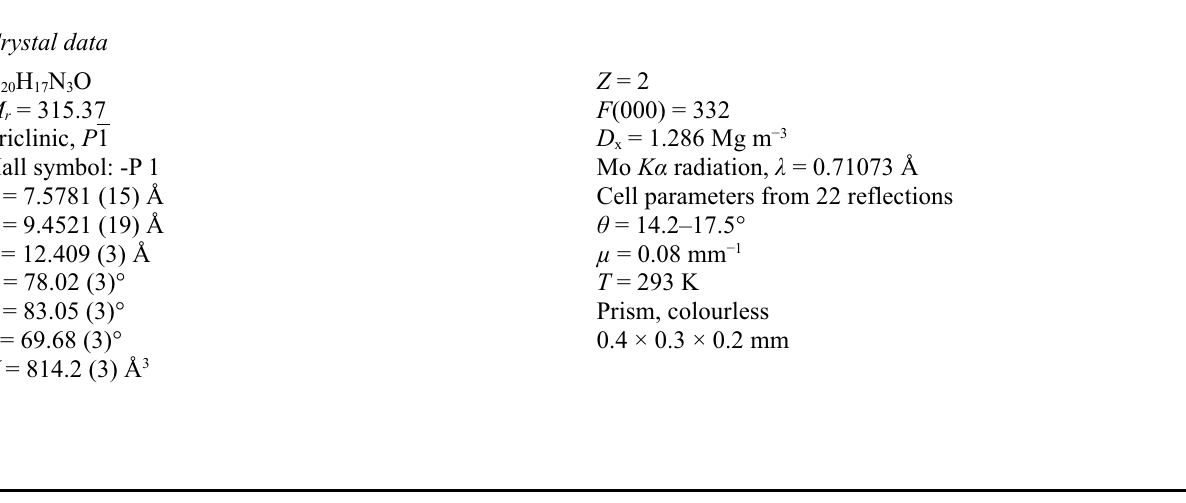
partial view of the crystal packing showing the formation of the infinite chain of molecules formed via hydrogen bonding [for clarifity only H atoms participating in bonding are depicted]. Symmetry codes: (i) x , 1 + y , z ; (ii) x , -1 + y , z